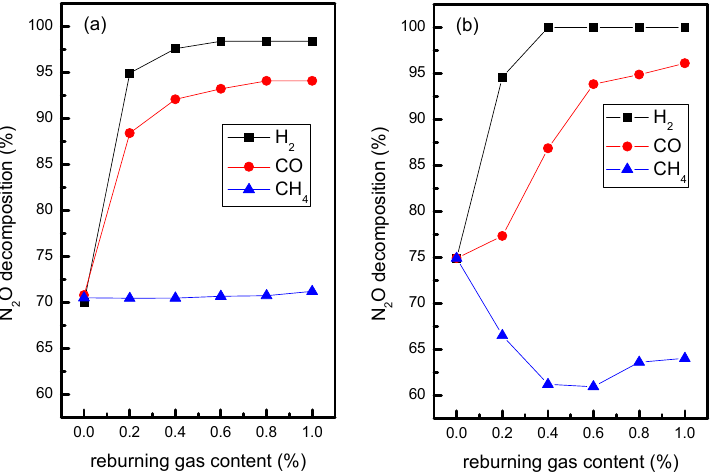
O decomposition and reburnig gas: ( a ) Homogeneous N 2 O decomposition with circulating ash 2 O = 2000 ppm, N O/N , 900 2 2 2